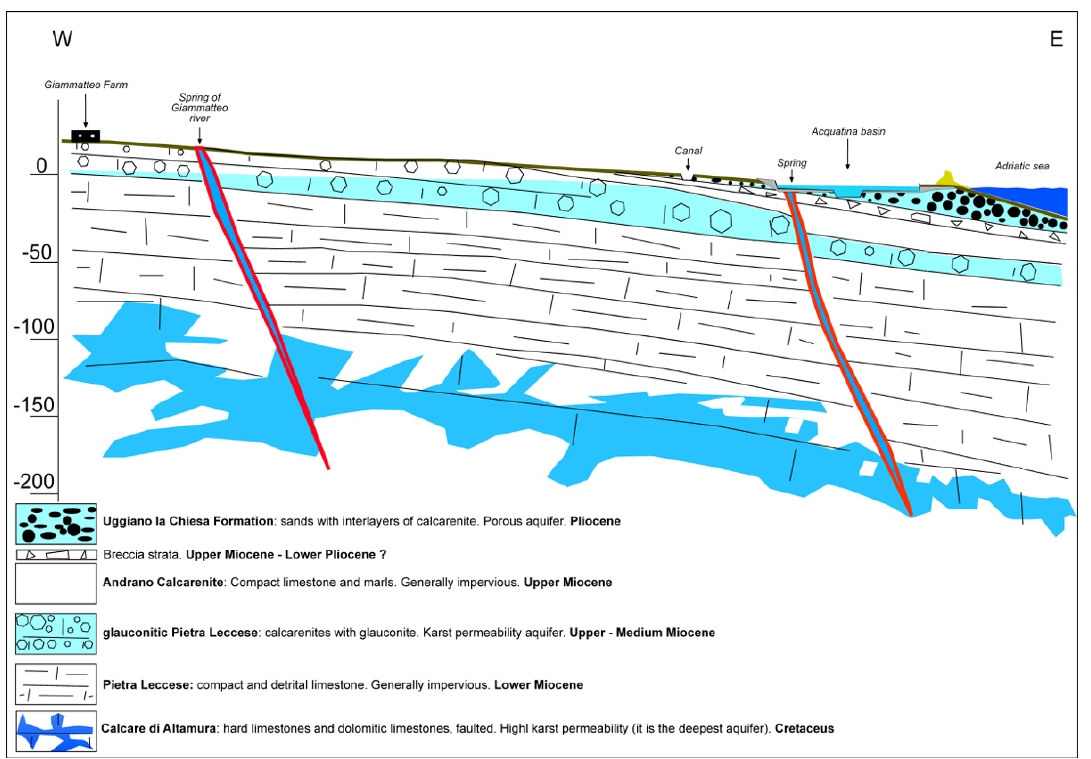
Figure 7. Schematic hydrogeological section of the studied area (not in scale). For the trace of the section see Figure 6. Red sub-vertical lines are faults, whilst the blue colors in the section indicate the presence of groundwater.